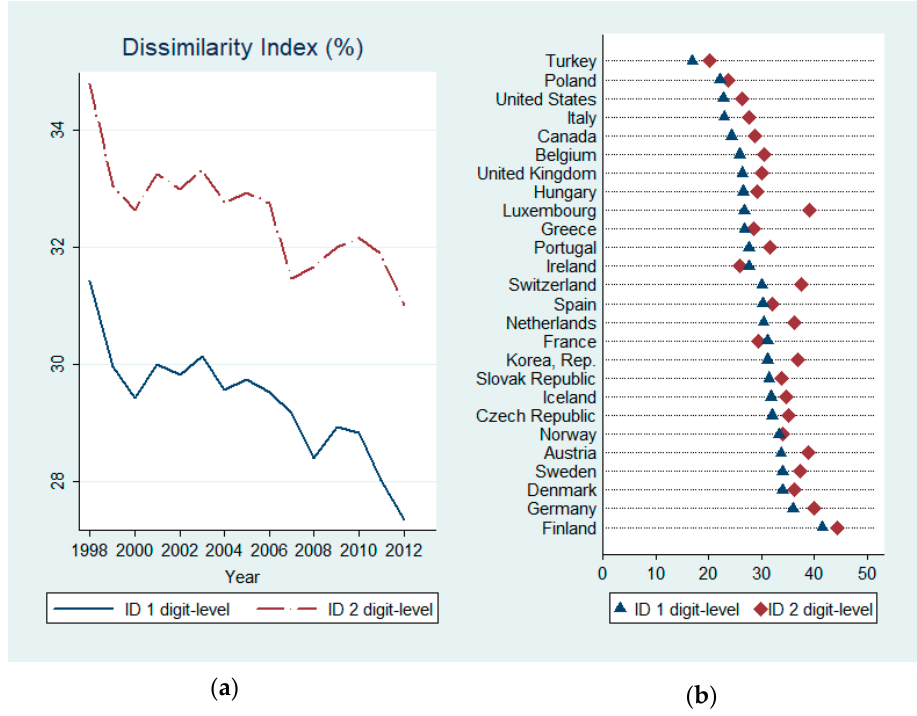
Figure 1. Country ‐ level Horizontal Gender Segregation. ( a ) Trend; ( b ) By country. Figure 1. Country-level Horizontal Gender Segregation. ( a ) Trend; ( b ) By